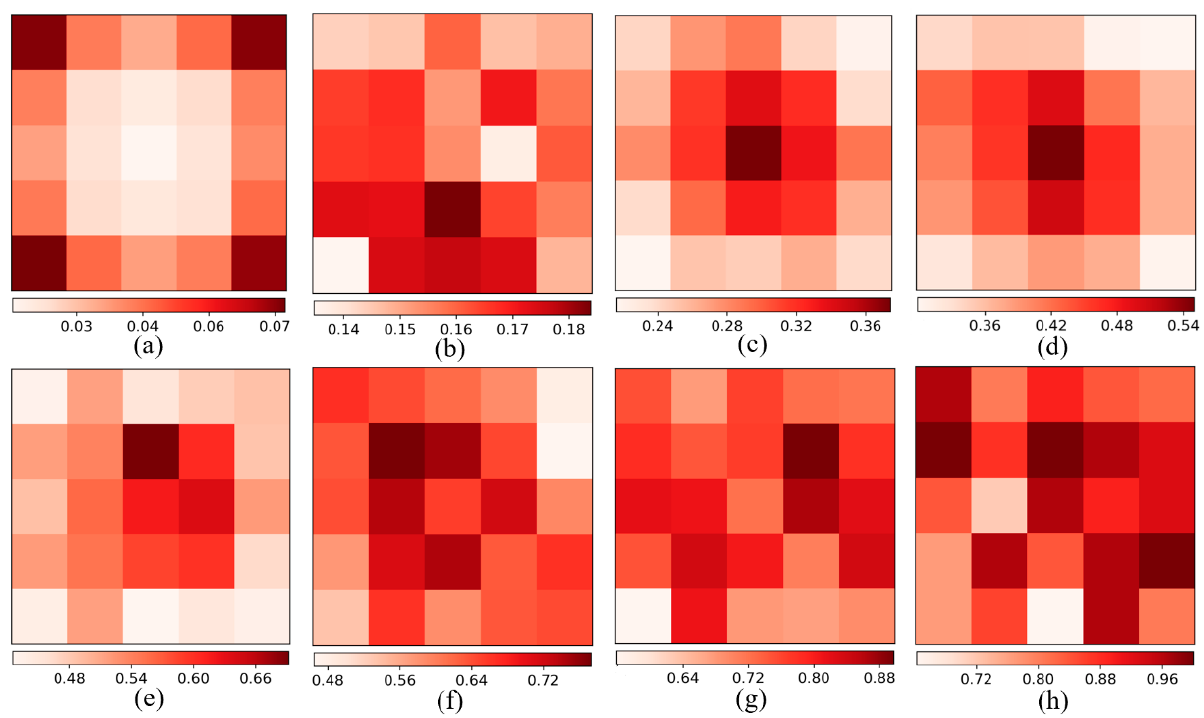
Figure 7. ( a – h ) show the probability of VIIRS fire pixel distribution among the Himawari-8 fire pix- els for fire pixel counts 1, 4, 7, 10, 13, 16, 19, and 22, respectively. The probability of fire pixel distri- bution in the figure is obtained by adding the 5 × 5 0–1 matrix of each fire pixel count and dividing it by the total number of corresponding Himawari-8 fire pixels.